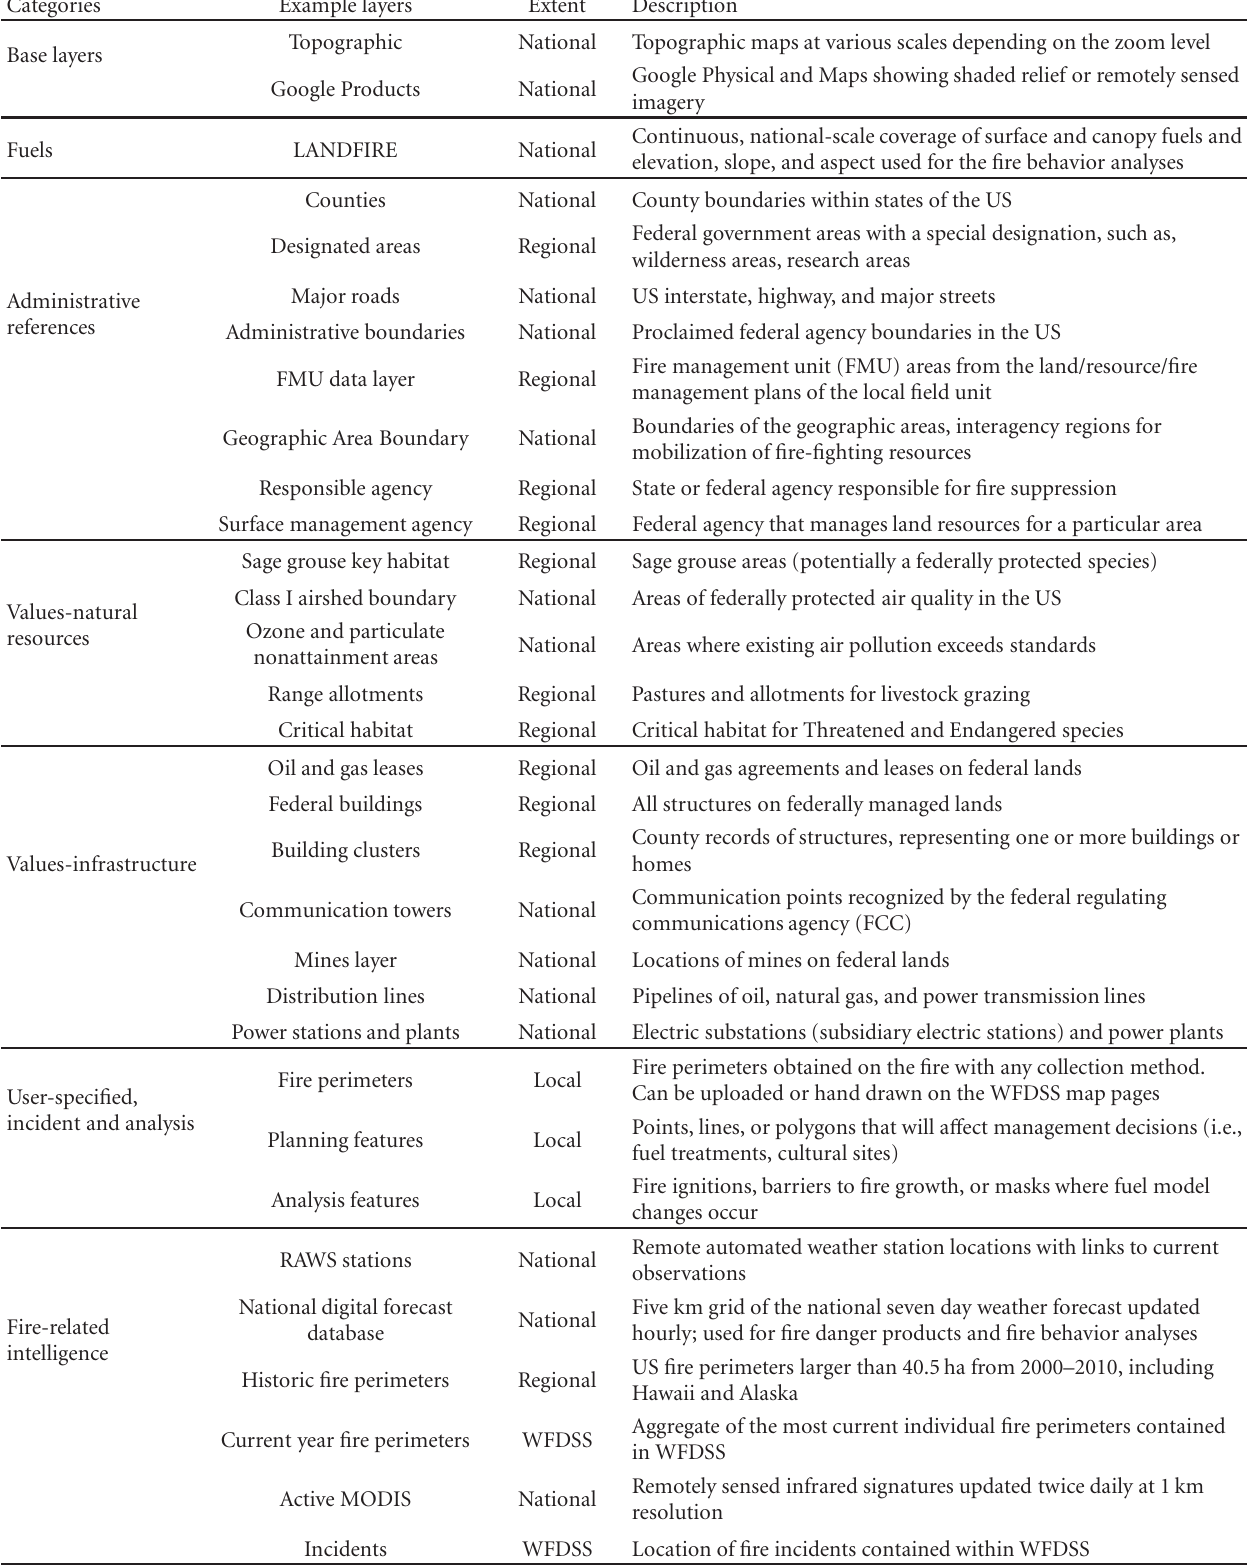
Table 2: Geospatial data layers in WFDSS. Available geospatial data layers range from national to local scales and include base layers, fuels, administrative references, values (natural resources and infrastructure), user-specified, and fire-related data. Examples of each category are provided with a short description. Extent refers to the spatial scale of the data